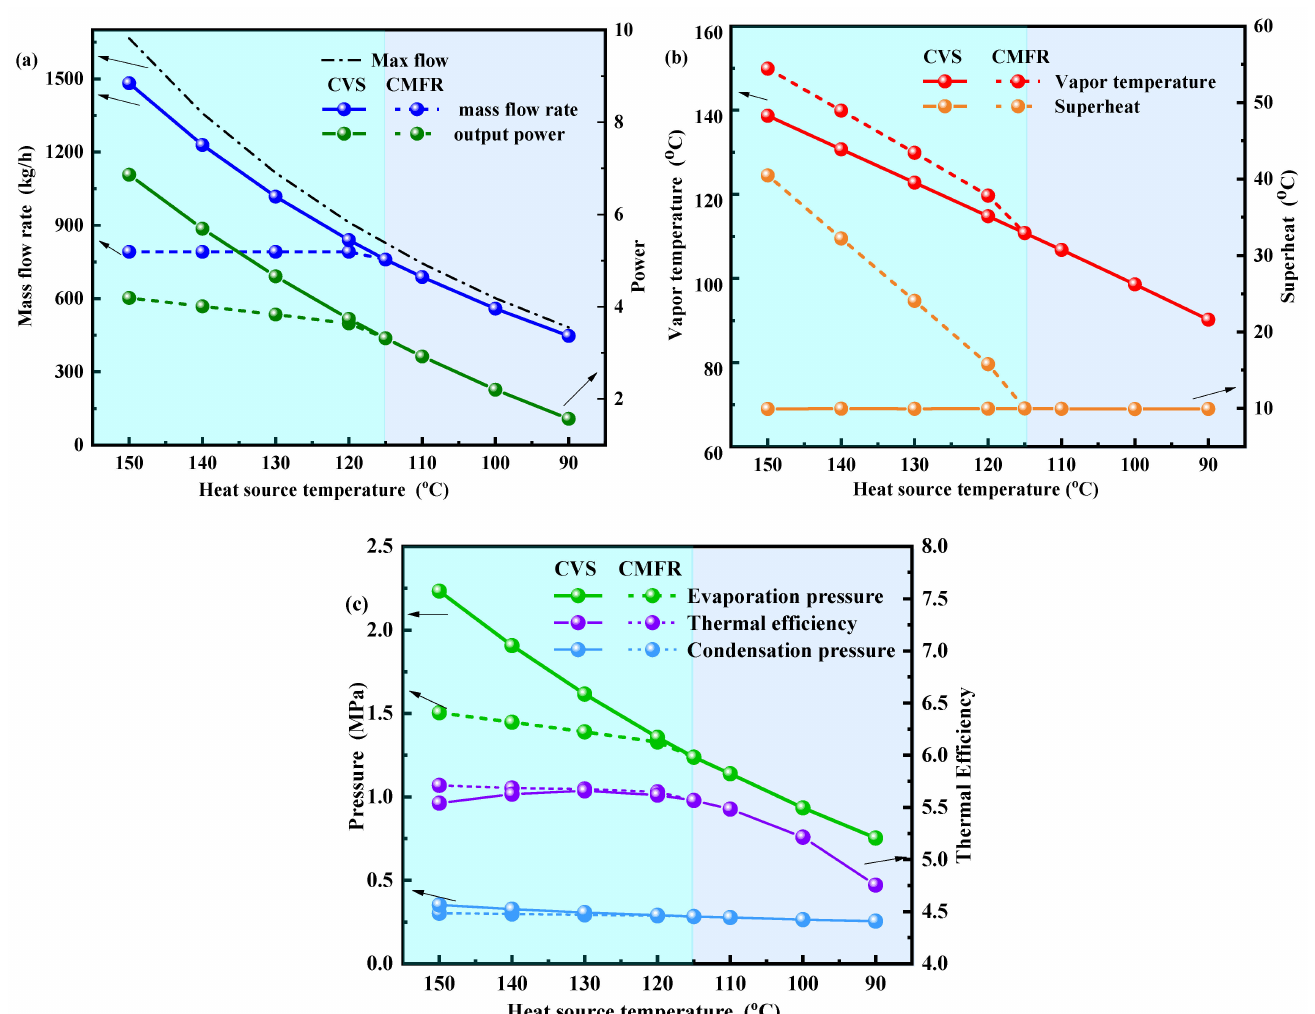
Figure 8. Variation of key parameters of the ORC system with heat source temperature under CVS and CMFR modes. ( a ) mass flow rate and power, ( b ) vapor temperature and superheat, ( c ) vapor pressure and thermal